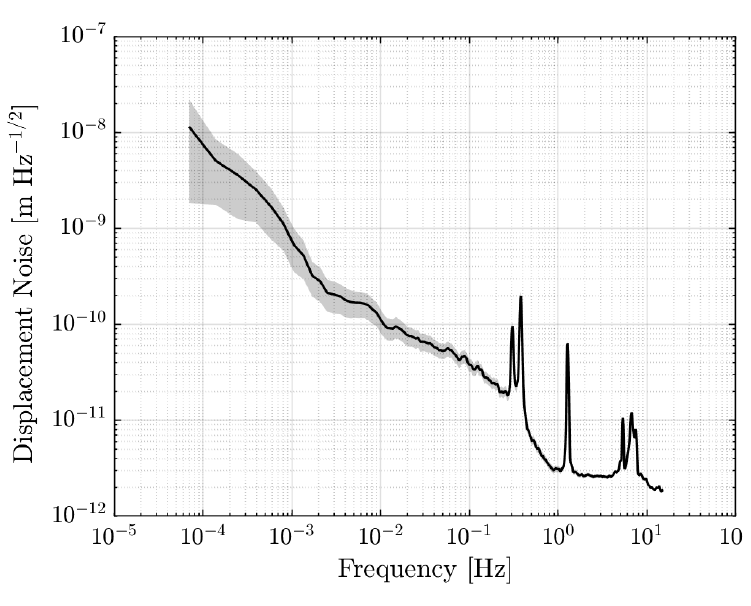
Figure 5. A plot of the displacement noise in our heterodyne interferometer. As this measurement was taken without our resonator, seismic noise was not present in the data. The shaded area represents the estimated error bars of the